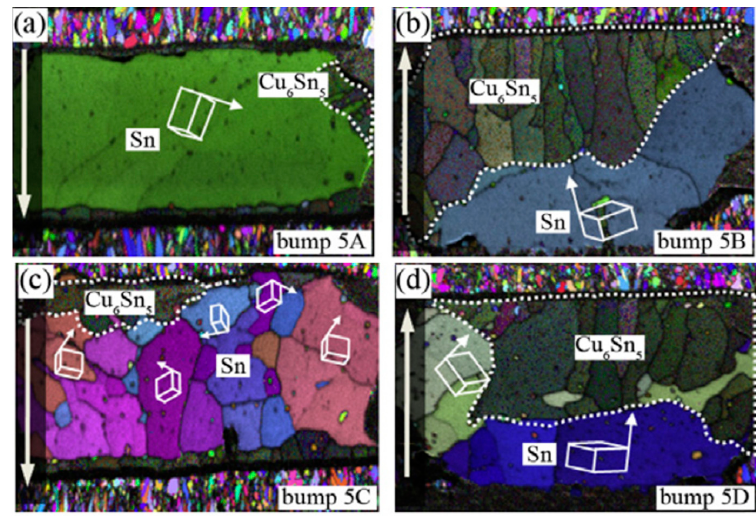
Figure 10. Sn inverse pole figure orientation maps of the bumps in test samples: ( a – d ) test sample 5 Reprinted with permission from Ref. [46] Copyright 2011, Elsevier.